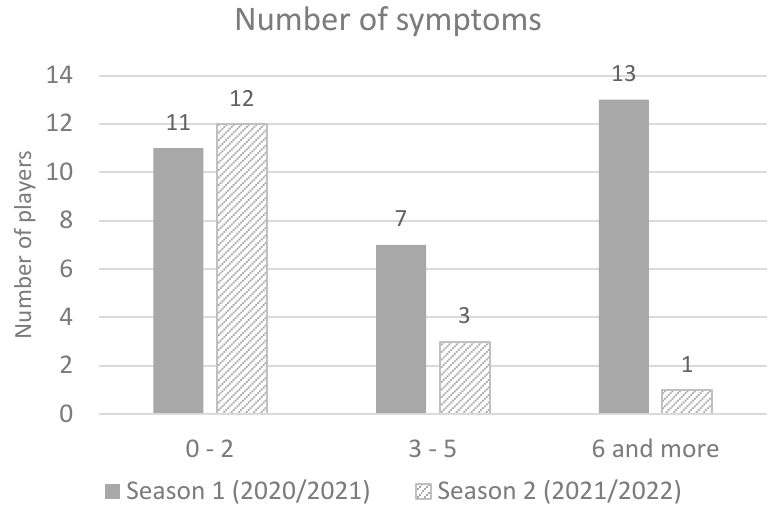
There was no report of cardiac or skin symptoms. The most of infected players in season 1 had six or more symptoms (41.9%), while in season 2 majority of infected players had up to two symptoms (68.75%) (Figure 2). A significant difference was found in the average number of reported symptoms per player (5.2 in season 1 vs. 2.1 symptoms in